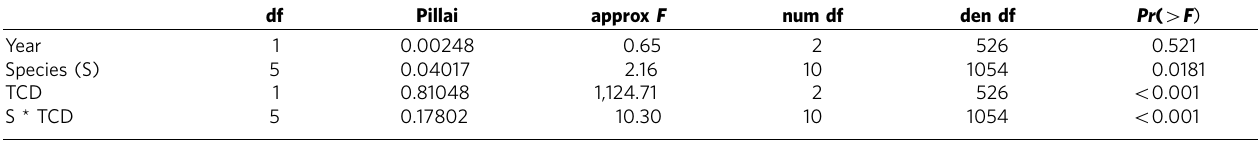
Table 2 | Temperature sensitivity of duration change for vegetative and reproductive phases.